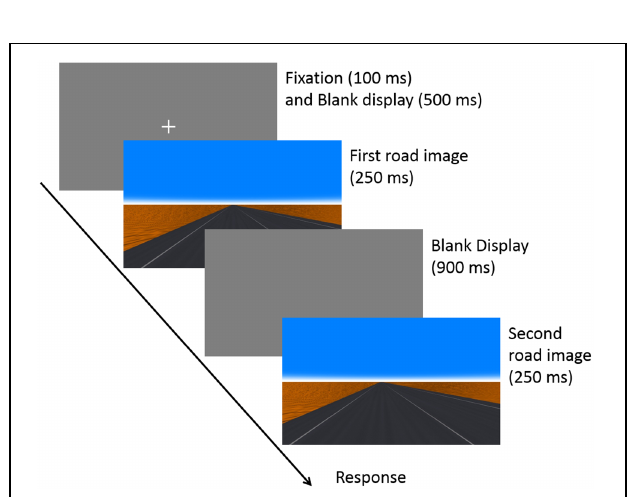
FIGURE 2 | Experimental sequence of a trial. In both tasks, two road images were sequentially presented for 250 ms with an intervening blank display (900 ms). Participants were instructed to judge which image was viewed straight in the front direction detection task, and to judge which image was viewed from the center of the lane in the center position detection